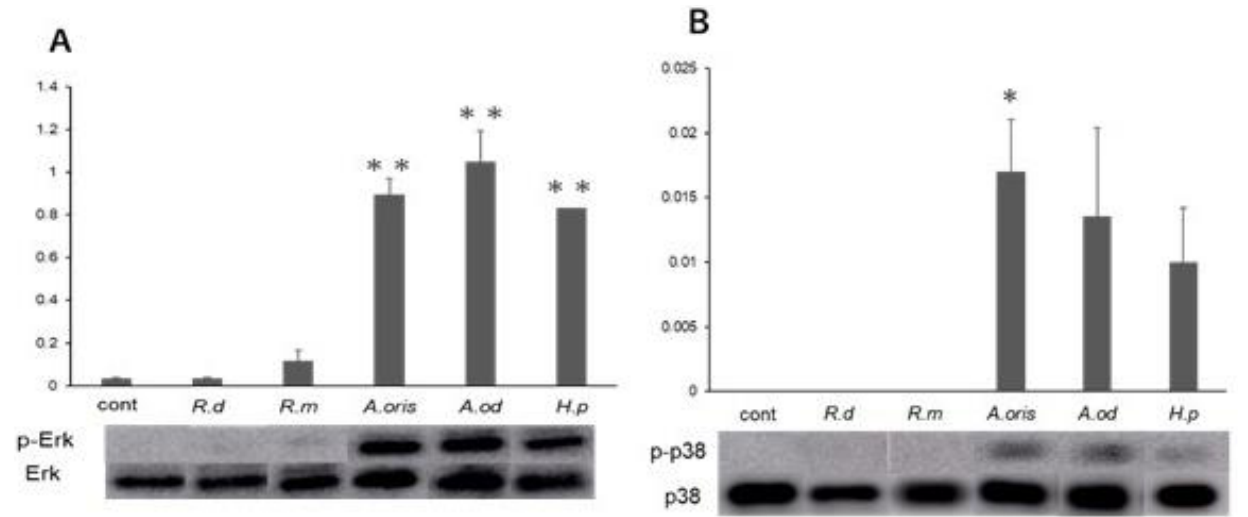
Figure 3. MAPK activity stimulated with each strain. Phosphorylation MAPK proteins were detected using Western blotting, and amounts of each protein expression ( n = 3) were measured using an Amersham Imager 600. ( A ) p-ERK/ERK, ( B ) p-p38/p38 (* p < 0.05, ** p < 0.01 vs. control).